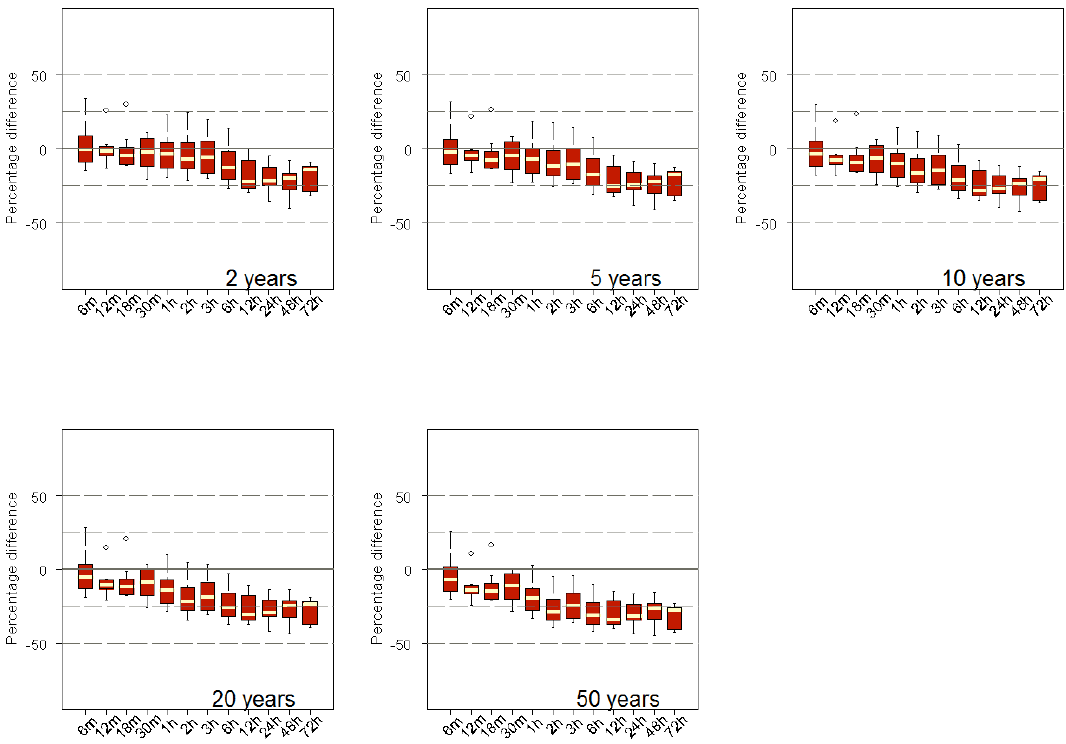
Fig. 4. Percentage difference between quantile estimates based on POT3 series for sites in the modified north cluster for five different return periods (2, 5, 10, 20, and 50yr). Negative values indicate a decrease from earlier to later